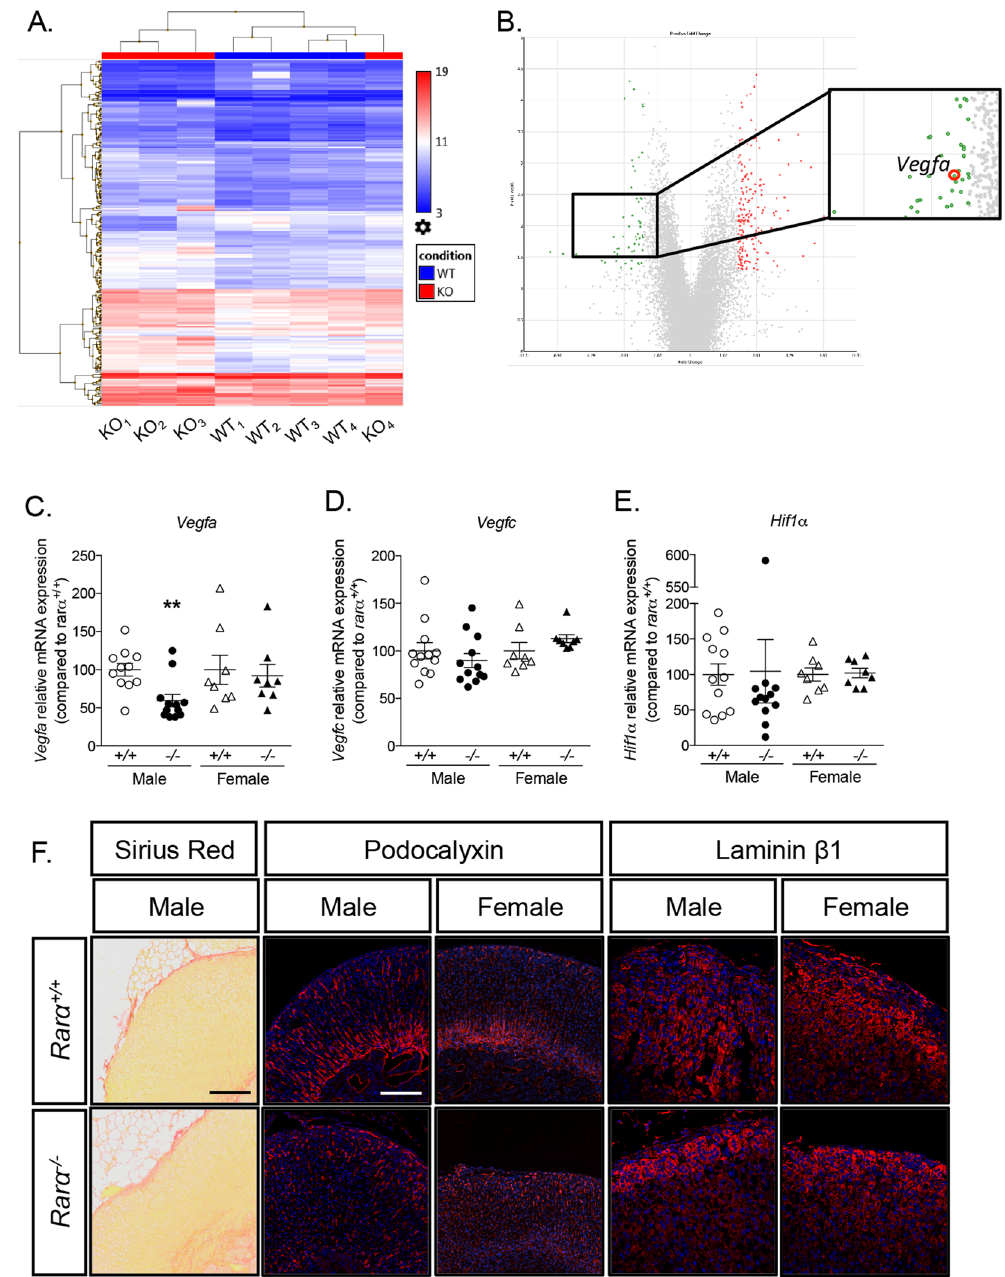
Figure 4. Rar α affects vessel architecture and extra cellular matrix composition. ( A ) Hierarchical clustering of samples using the 243 differentially expressed genes in adrenals from 12 weeks old Rar α + / + and Rar α - / - male animals (4 animals per group). ( B ) Volcano plot showing the differentially expressed genes in 12 weeks old Rar α + / + and Rar α - / - animals. The x-axis is the fold change between the two conditions; the adjusted p value based on –log 10 is reported on the y-axis. Genes significantly different are highlighted as green (down-regulated in Rar α - / - mice) or red (up-regulated in Rar α - / - mice) dots. (C, D, E) The expression of genes involved in angiogenesis, Vegfa ( C ) and Vegfc ( D ) and in hypoxia, Hif1 α ( E ) was investigated by RT-qPCR on mRNA extracted from 6–11 adrenals from 12 weeks old male and female Rar α + / + and Rar α - / - mice. ( F ) The vascular architecture was assessed by Sirius red staining and podocalyxin immunofluorescence and extra cellular matrix integrity by laminin β 1 immunofluorescence. Values are presented as the mean ± SEM; p values were calculated using a Mann-Whitney test. ** p <